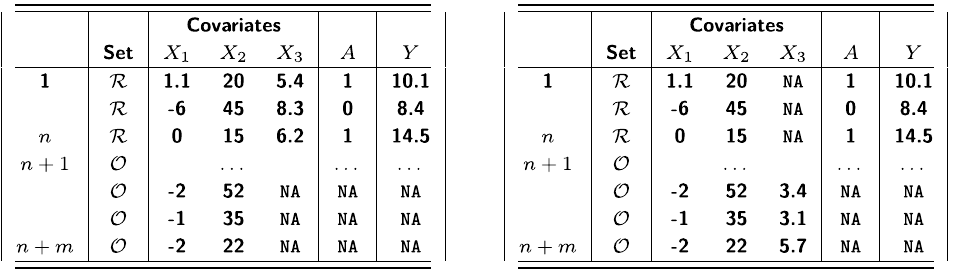
Figure 1: Typical data structure, where a covariate would be available in the RCT, but not in the observational data set ( left ) or the reverse situation ( right ) . In this speci fi c example, obs 1, 2 { } = ( mis 3 { } = ) , corresponds to common ( resp. di ff erent ) cov - ariates in the two